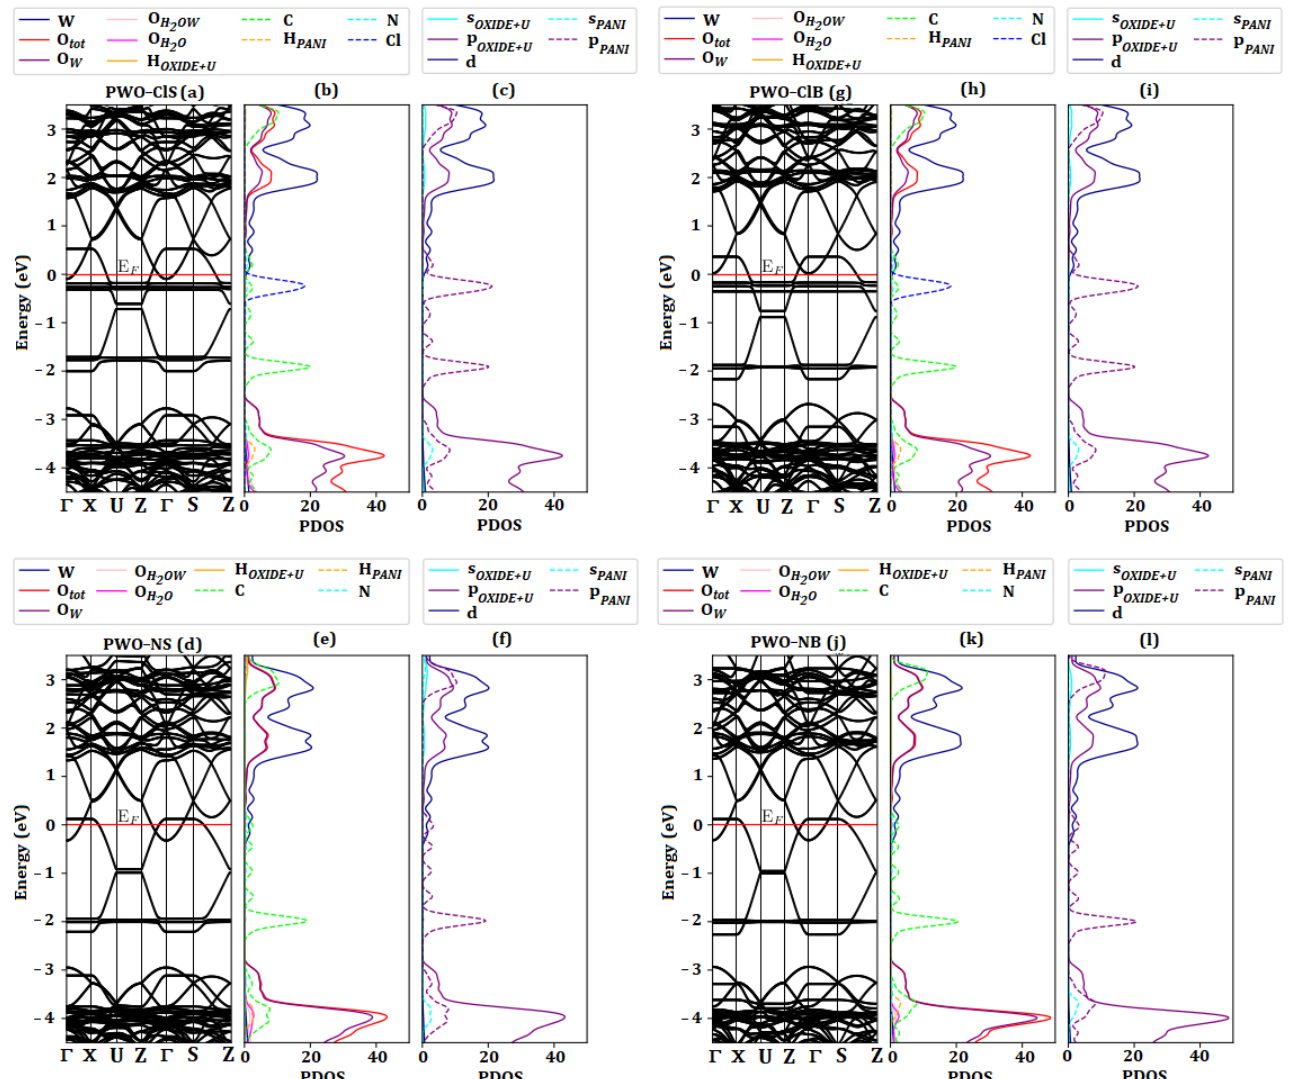
Figure 9. ( a , d ) Band structure, ( b , e ) PDOS for atoms and ( c , f ) PDOS for orbitals of PWO–ClS and PWO–NS systems. The counter ions caused a marginal energy difference in the Fermi level, shifting the position of the highest occupied state. The PDOS showed that the p –orbitals of the Cl and C atoms of the doped and undoped polymer phases, respectively, were responsible for promoting the electrons to the d –orbitals of the W atom. ( g , j ) Band structure, ( h , k ) PDOS for atoms and ( i , l ) PDOS for orbitals of PWO–ClB and PWO–NB systems. The counter ions caused a marginal energy difference in the Fermi level, shifting the position of the highest occupied state. This change was also attributed to the variation in the unit cell parameters. The PDOS showed that the p –orbitals of the Cl and C atoms of the doped and undoped polymer phases, respectively, were responsible for promoting the electrons to the d –orbitals of the W atom.